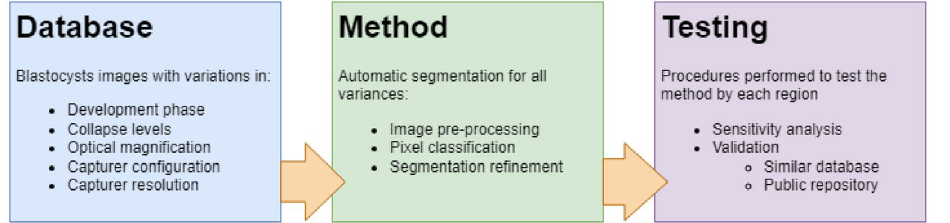
Figure 4. Overview of the materials and methods used in the